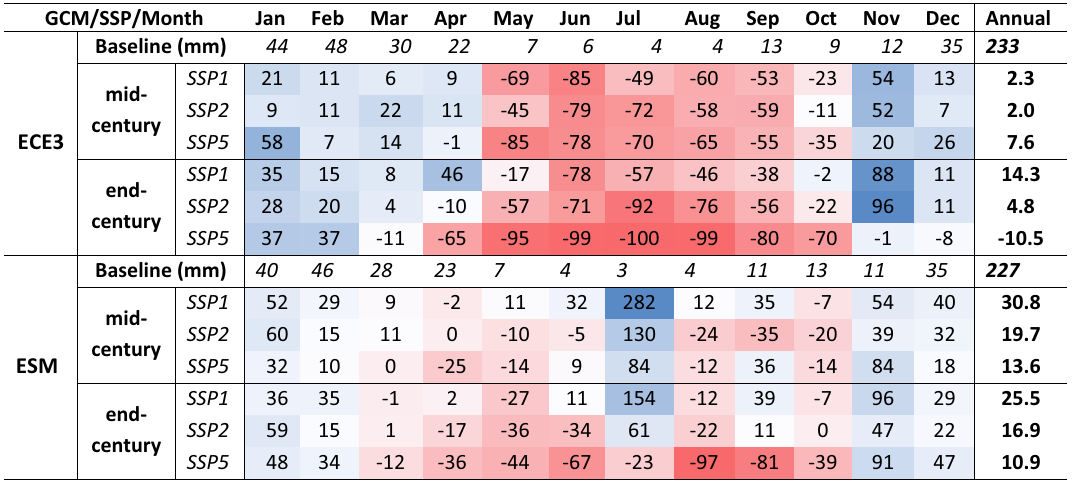
Table 4. Percentage changes in mean monthly future SWE relative to the baseline for all scenarios based on both GCMs.